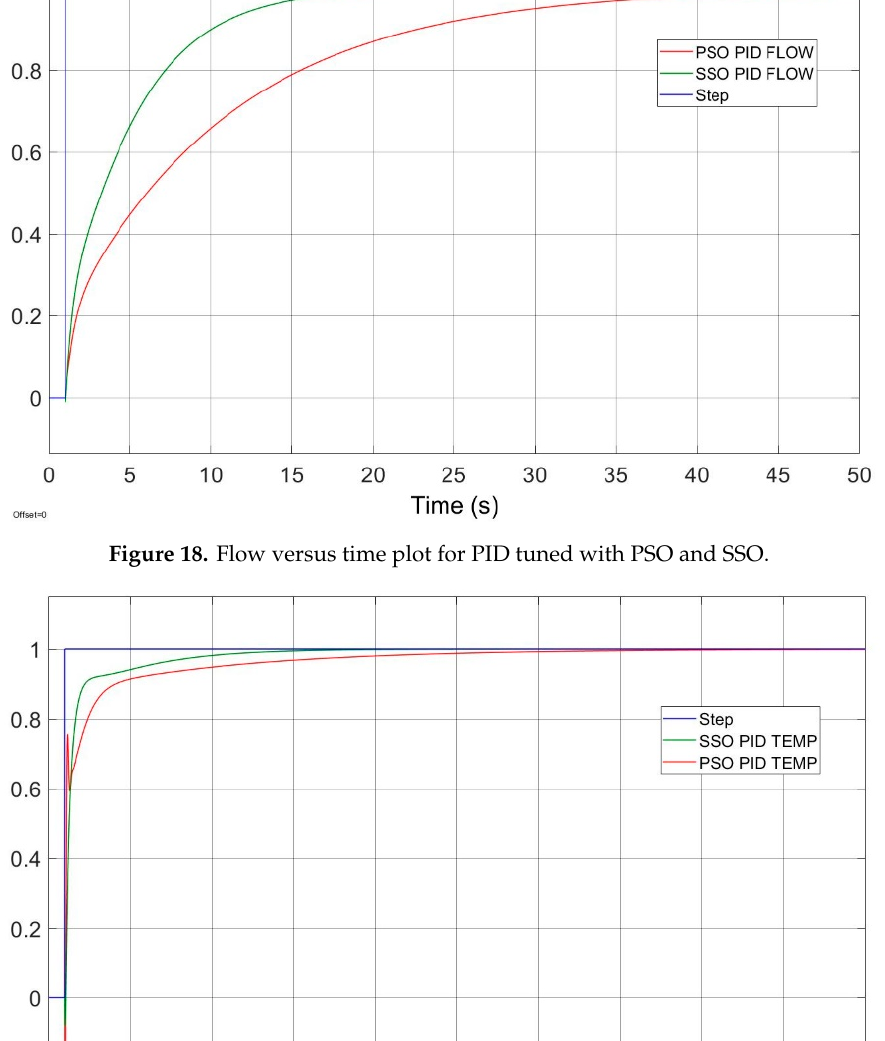
Figure 17. Temperature versus time plot for PID tuned with Zeigler–Nicholas.